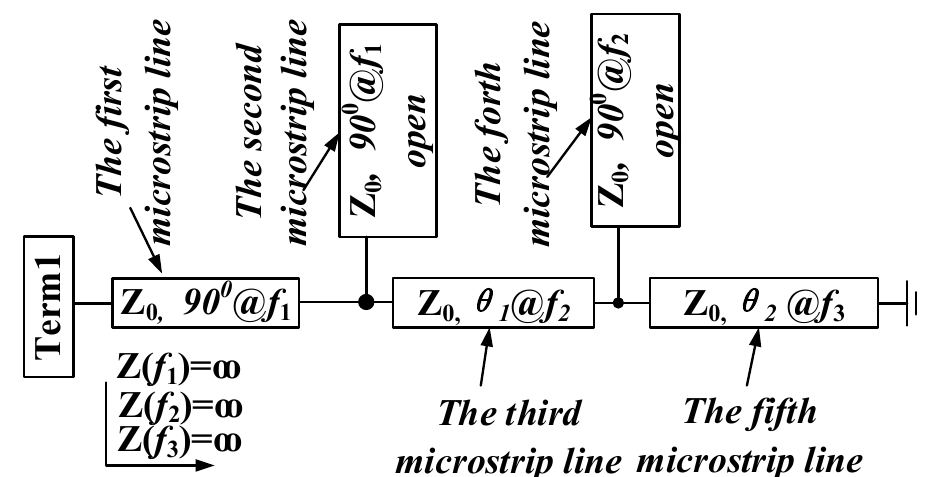
Figure 5. Biasing circuit network structure.